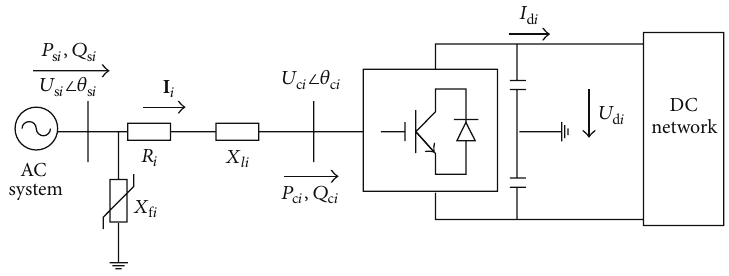
Figure 1: Simplified circuit diagram of single-phase